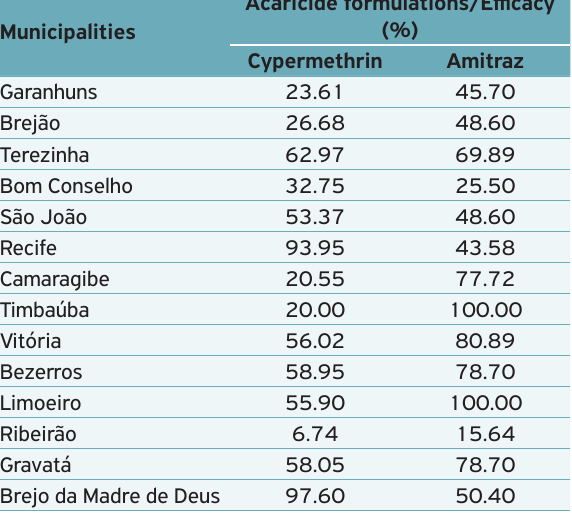
Table 1. Mean efficacy (%) of acaricides formulations against Rhipicephalus ( Boophilus ) microplus from different municipalities of Pernambuco,